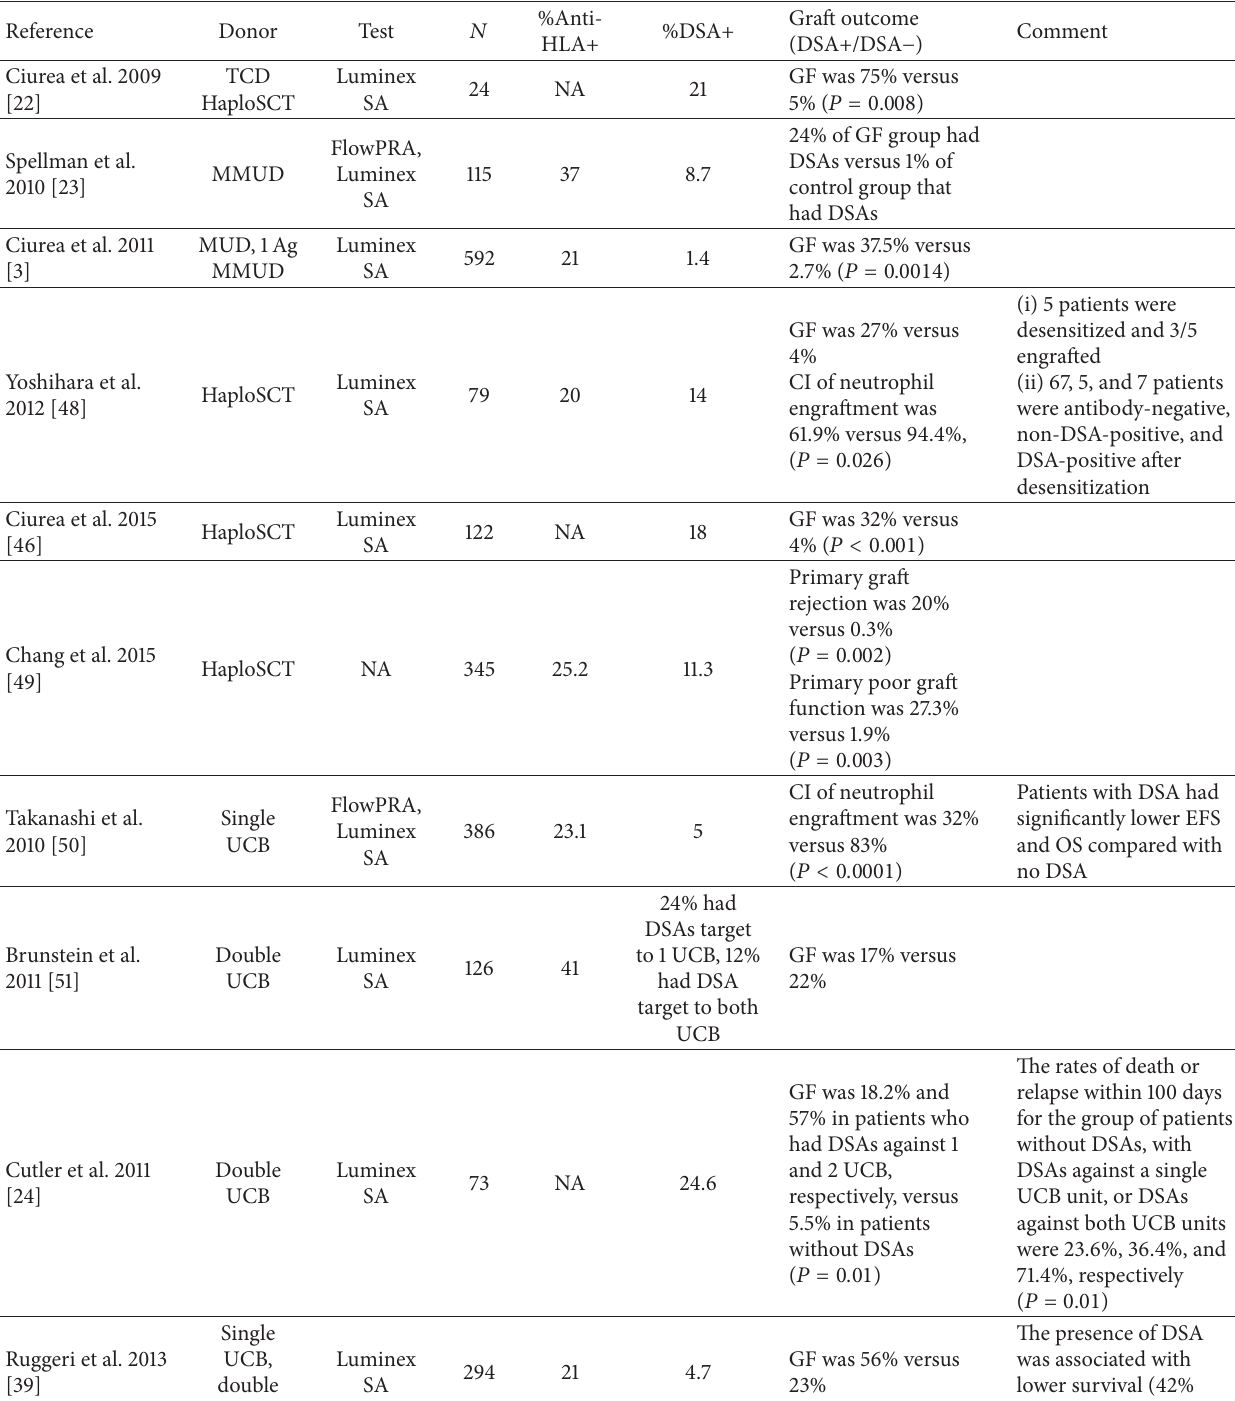
Table 1: DSAs and transplant